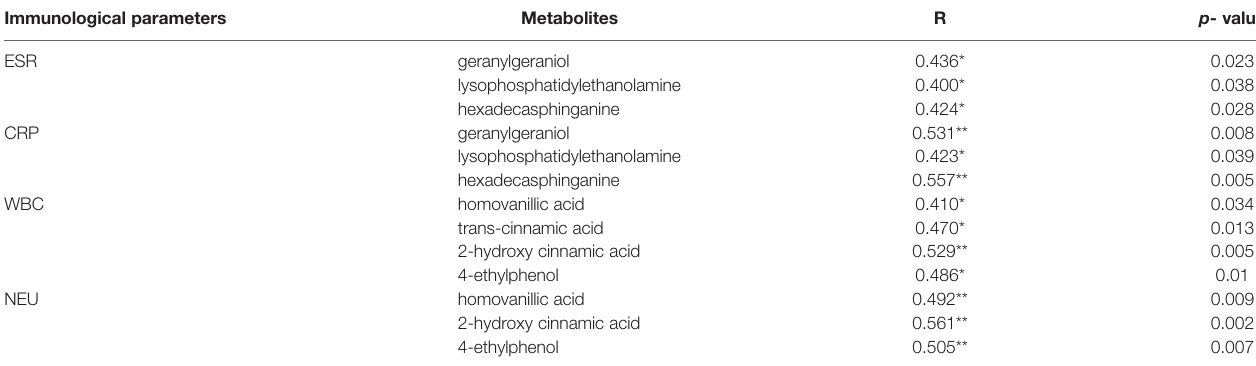
TABLE 3 | Pearson ’ s correlation analysis between differentially altered metabolites and immunological